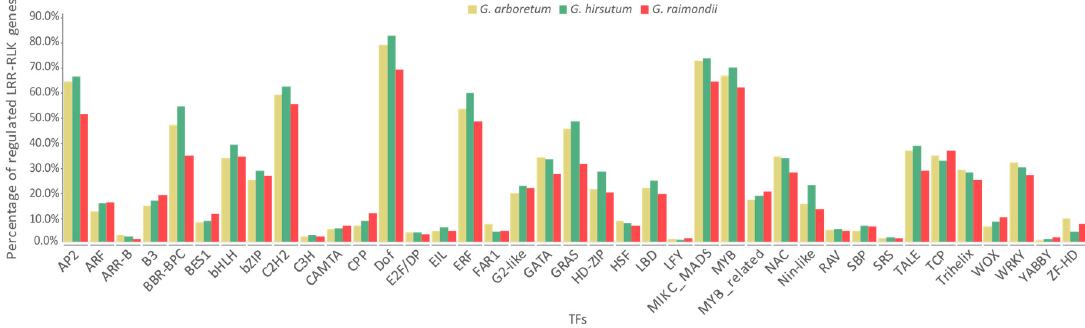
Figure 5. Statistics of Gossypium LRR-RLK genes regulated by different families of transcription factors (TFs) (genes with TF binding sites were considered to be regulated by TFs).